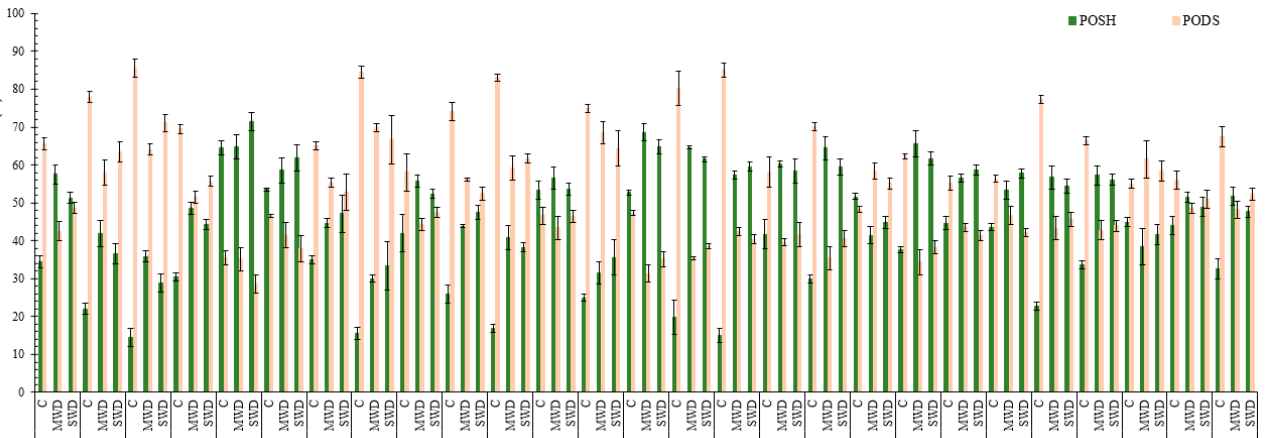
Figure 6. Water treatment (WT) × genotype interaction effect on dehulled seed fatty acid content (DSFAC), hull fatty acid content (HFAC), and whole fatty acid content (FAC). C: control; MWD: moderate water deficit; SWD: severe water deficit. L 1 –L 3 : 3 testers, G 1 –G 6 : 6 male parents; L 1 G 1 –L 2 G 6 : 12 single hybrids, and L3G1–L3G6: 6 three-way hybrids in a modified triple test cross.